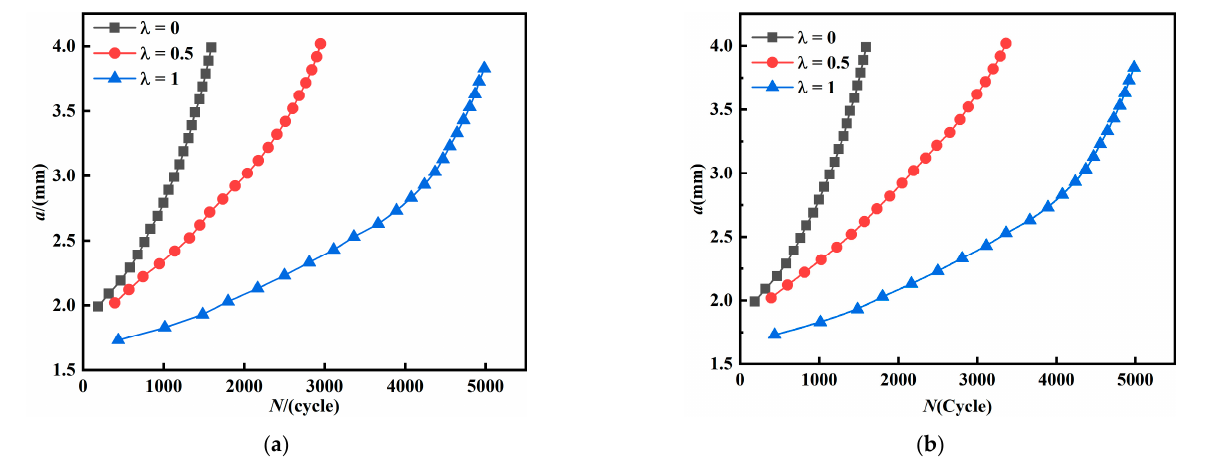
Figure 9. a-N curves under crack inclination β = 60°, 45°. ( a ) a-N curves ( β = 60°), ( b ) a-N curves ( β = 45°).